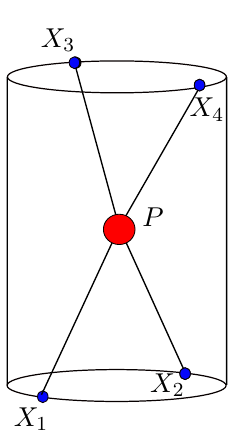
Figure 5. Bulk-point kinematics in Lorentzian cylinder of AdS. X 1 and X 2 are at Lorentzian time − π/ 2 , X 3 and X 4 are at Lorentzian time π/ 2 , where particles are focused on the bulk-point P